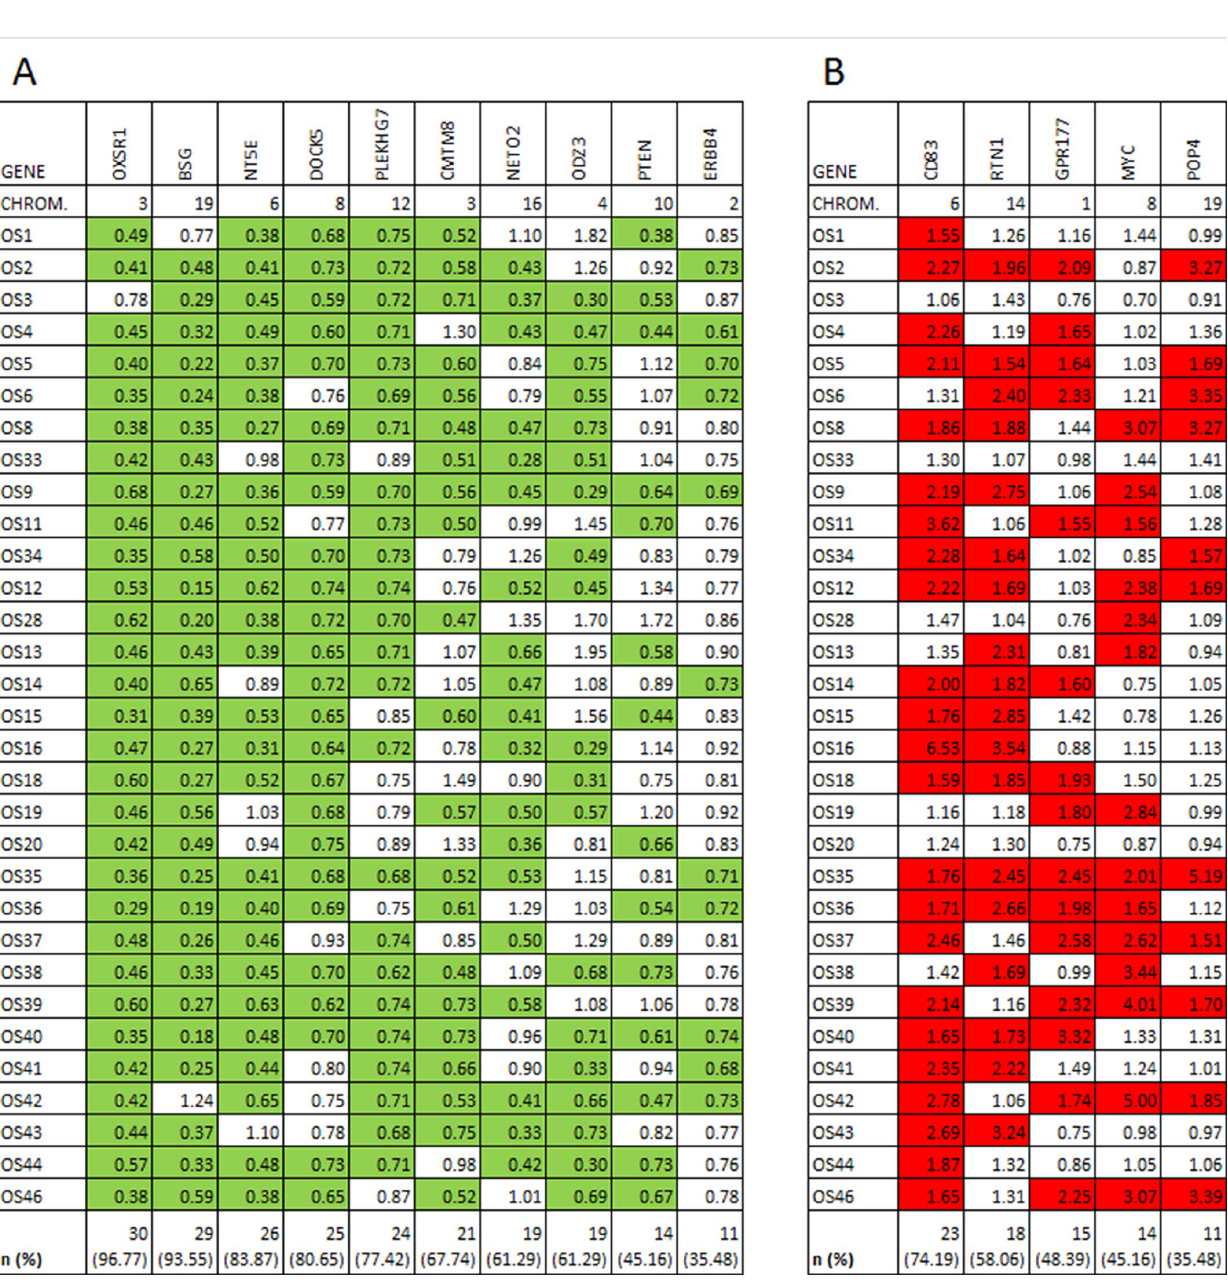
Fig. 3. Genes in focal losses with underexpression (FC , 0.75, A) and in focal gains with overexpression (FC . 1.5, B) in more than 35% of osteosarcomas. Green: expression fold change (FC) , 0.75 of the gene in the tumor relative to osteoblasts (underexpression). Red: expression fold change (FC) . 1.50 of the gene in the tumor relative to osteoblasts (overexpression). For each gene, the number (n) and fraction (%) of osteosarcomas with the indicated fold change (FC) are